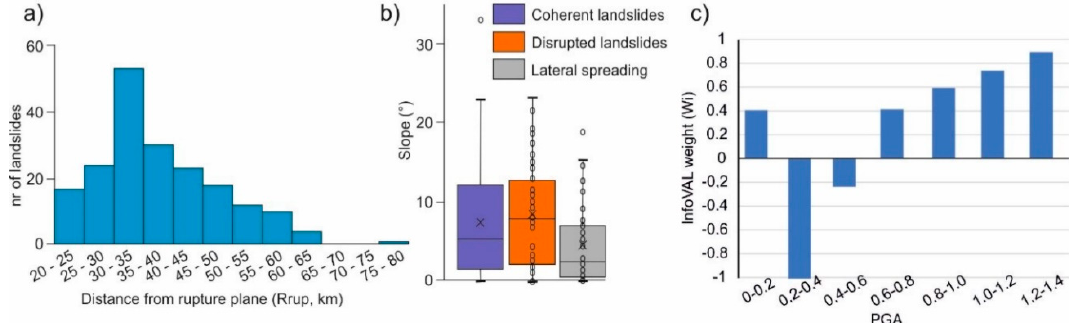
Figure 9. Landslides occurrence per ( a ) distance from the rupture plane (Rrup), ( b ) slope values and c ) InfoVAL weights for PGA-h values.